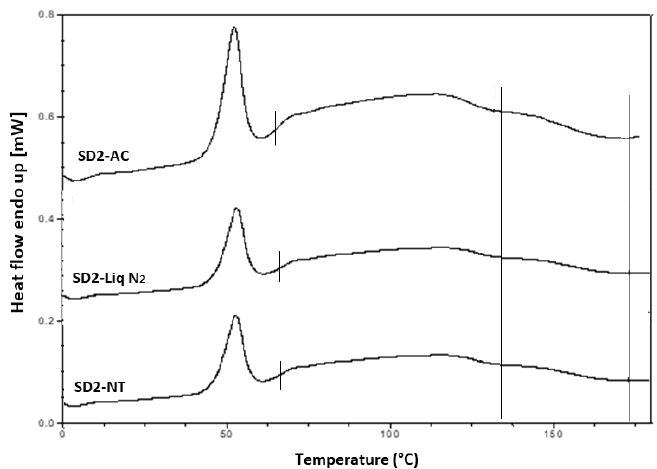
Figure 16. Hyper DSC thermograms of selected SD formulations used to investigate the e ff ect of cooling after 5 months of a stability study under accelerated conditions of 40 ◦ C and 75% RH. P407 is was still present in its crystalline form in all formulations (AC = Air cooled, NT = Normal room temperature and Liq N 2 = Liquid Nitrogen). The area of interest for crystalline INM melting endotherm is marked by straight lines. T g is indicated by a tick.